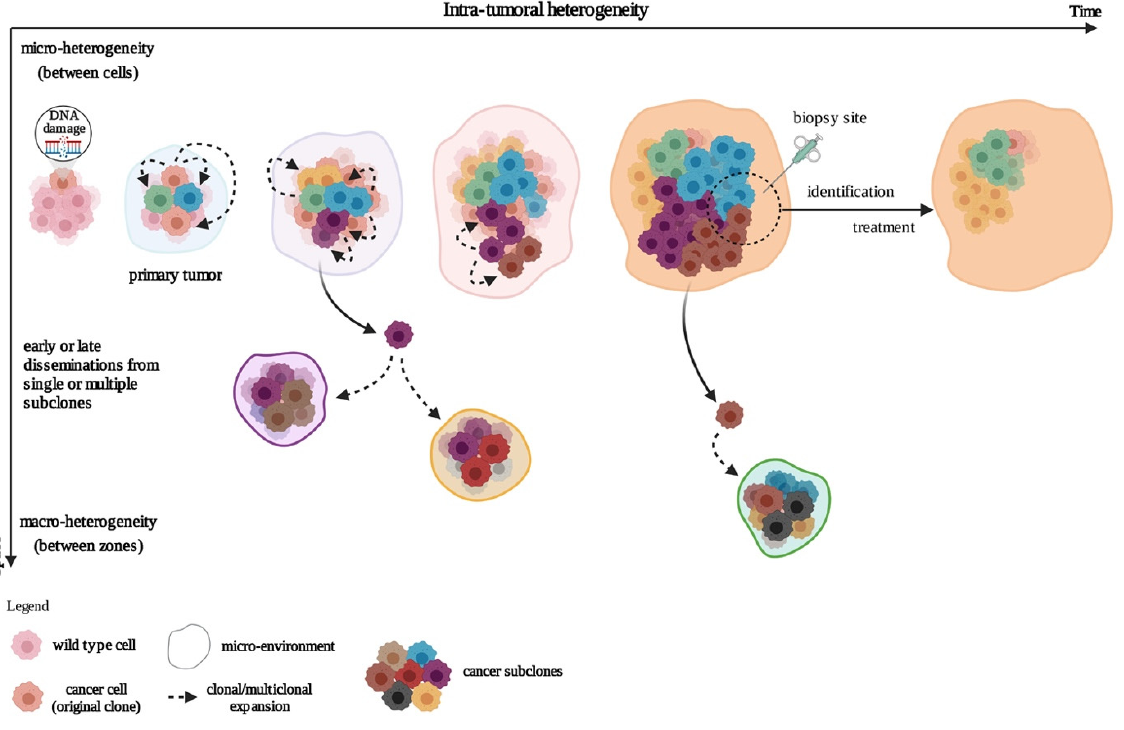
Figure 1. Development of the intra-tumoral heterogeneity. In the clonal evolution model, tumor cells arise from a single mutated cell and acquire additional varied mutations as they progress. This can occur in a linear fashion (not represented) whereby the cells successively acquire mutations that confer a growth or survival advantage, or through a branched mechanism, giving rise to multiple genetically diverse subclonal populations. Created with BioRender.com (accessed on 4 January 2021).